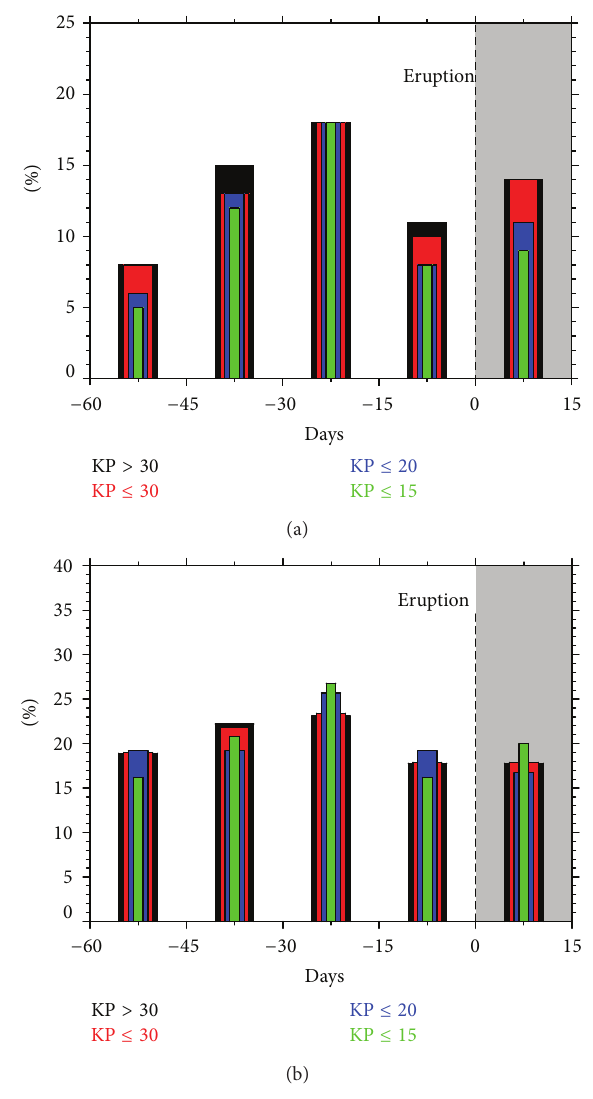
Figure 7: (a) Percentage of type 1 anomalies by 15-day periods between 60 days before the onset of eruptive activity and 15 days after. (b) Percentage of type 2 anomalies by 15-day periods between 60 days before the onset of eruptive activity and 15 days